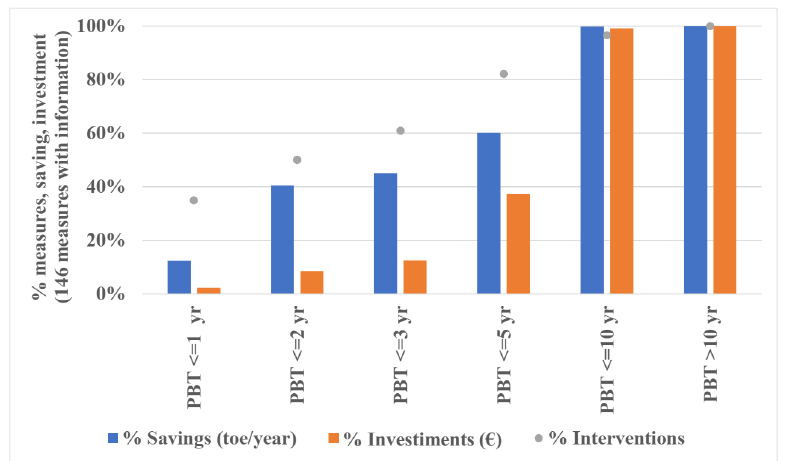
Figure 8. Cumulative saving and investment according to PBT